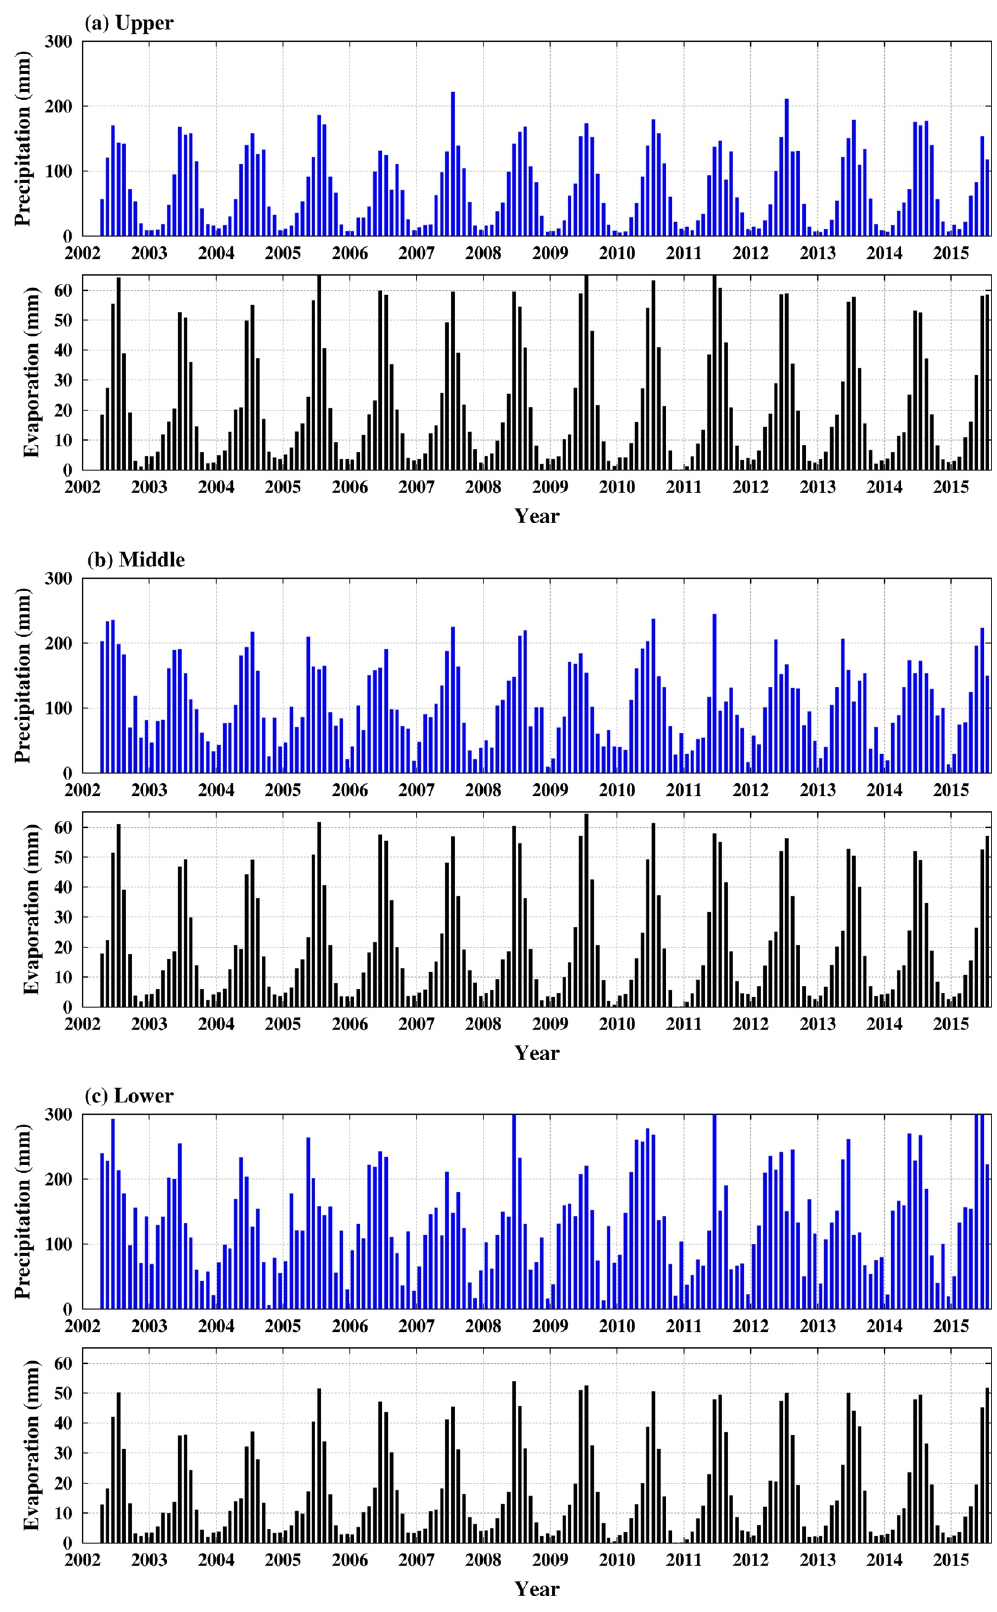
Figure 3. Time series of precipitation and evaporation in the ( a ) upper, ( b ) middle, and ( c ) lower sub ‐ basins of the YRB from April 2002 to July 2015.